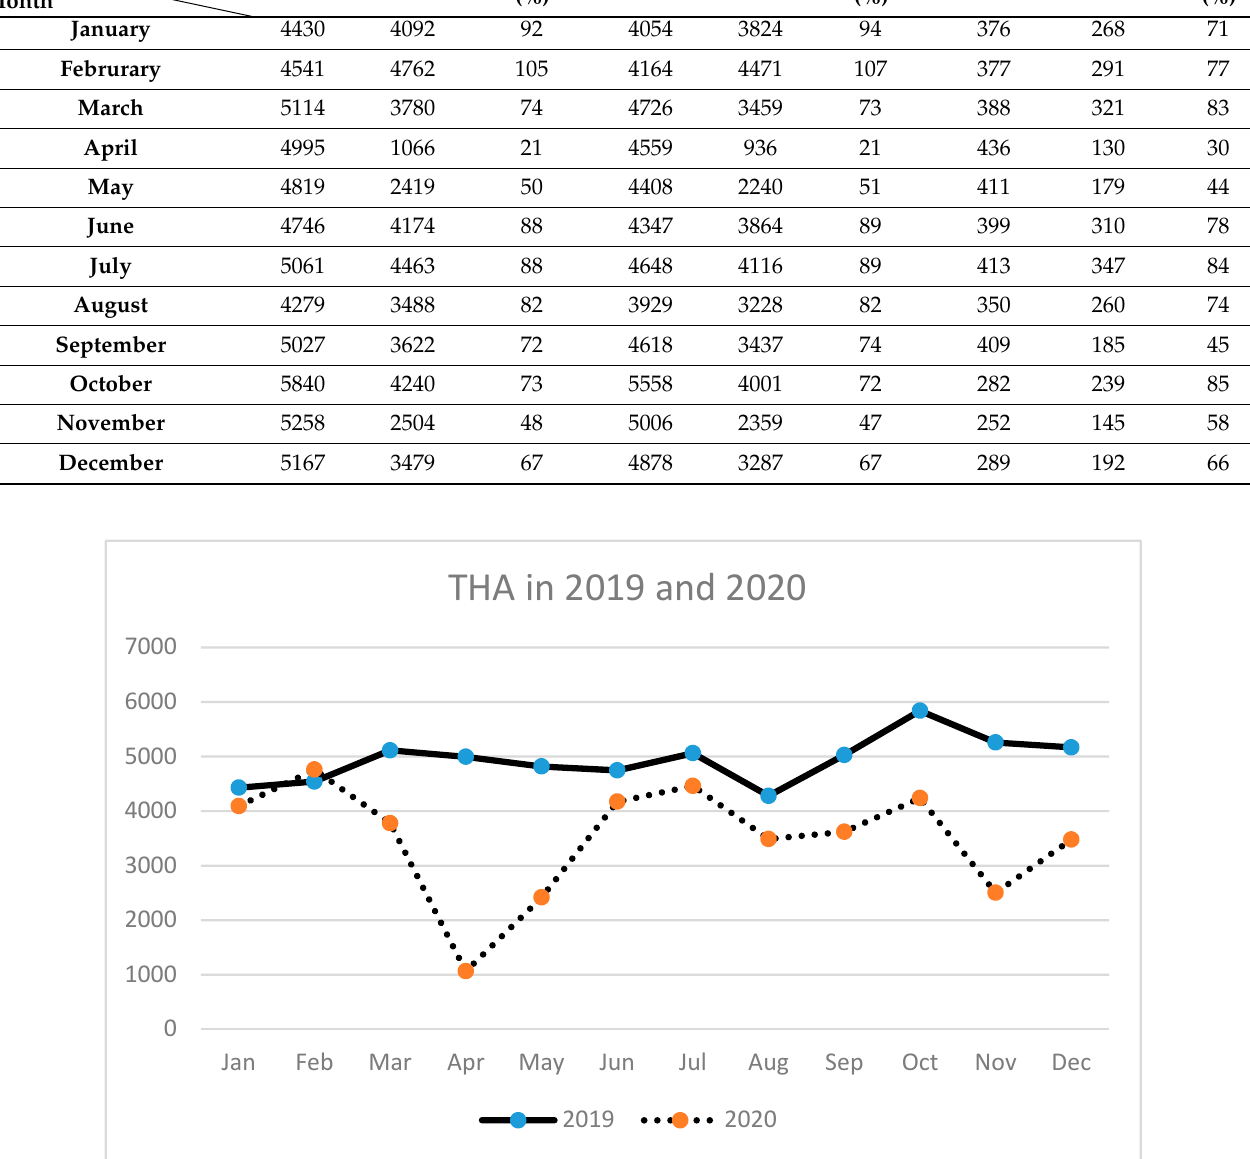
Figure 2. Number of total hip arthroplasties (THA) performed in the particular months of 2019 and 2020 in Poland.